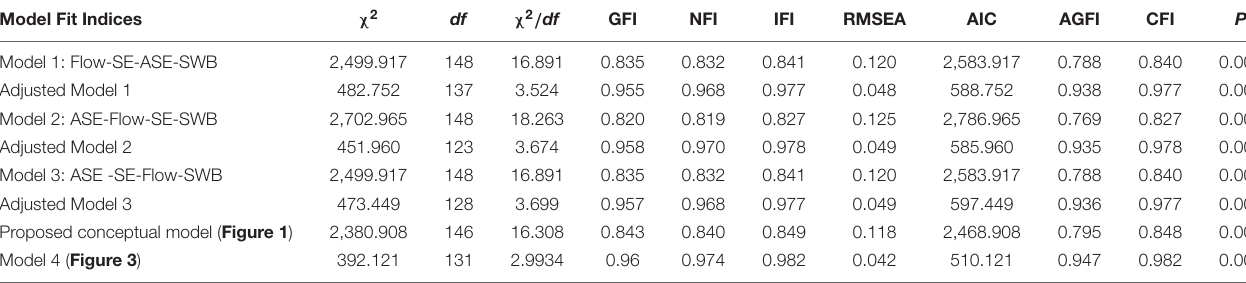
TABLE 4 | Fitting indices for the proposed model and adjusted model ( N = 1,109).